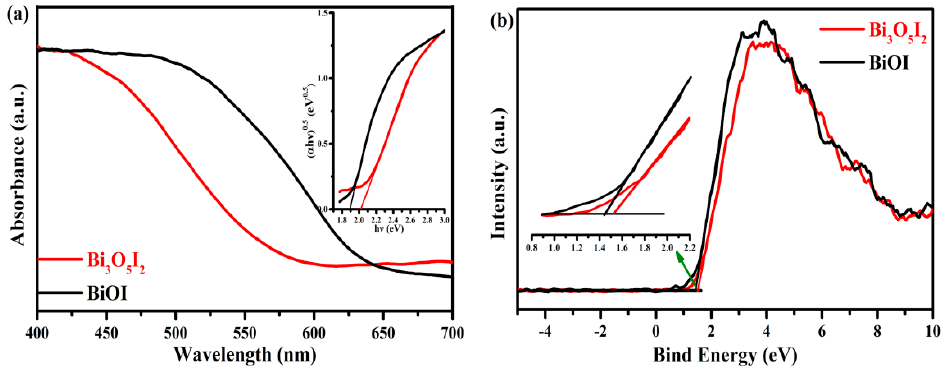
Figure 7. ( a ) Diffuse reflectance spectra and band gaps of Bi 3 O 5 I 2 and BiOI (inset), ( b ) valence band XPS spectra of Bi 3 O 5 I 2 and BiOI. XPS spectra of Bi 3 O 5 I 2 and